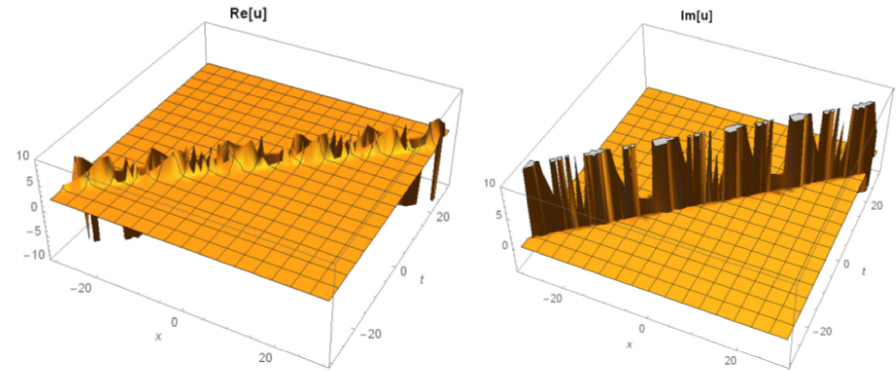
Figure 14. The 3D simulations of Equation (26) under the values of ε = 0.4, − 30 < x < 30, − 30 < t <